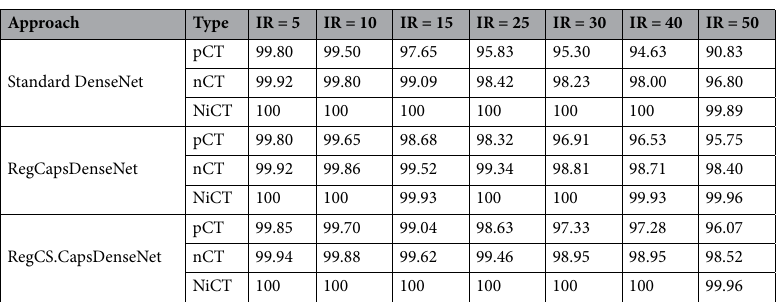
Fig. 2 shows the Cost-sensitive regularized margined loss for our RegCS.CapsDenseNet method in the presence of imbalanced data. However, we expect a bigger loss for a bigger IR. Still, our approach is almost stable with enough learning processes. The training error is significantly reduced at the beginning of epochs and continues with a smoother slope in the following training epochs. We also generated the Receiver Operating Characteristic (ROC) curves obtained by our RegCS.CapsDenseNet method in Fig. 3 where the ROC curve of HUST dataset with its Area Under the Curves (AUC) rates is shown in subfigure (a), and the curves in (b) to (h) are regarding the protocol II with different IRs. In the ROC curve, the point of (0, 1) based on the Cartesian plane indicates the highest sensitivity and specificity; therefore, as can be seen, our method obtained a reasonable classification rate. Finally, to show the correlation between classes, we provided our evaluation confusion matrices in Fig. 4. In this figure, the confusion matrix (a) is related to the first protocol, and comparable with the original work 32 . Other remained seven confusion matrices (b) to (h) are related to the seven different IRs in the second protocol